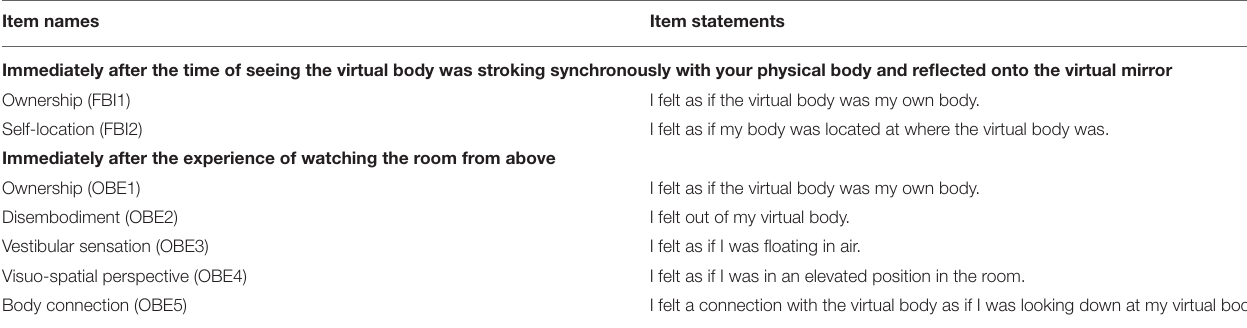
TABLE 1 | The list of self-report questionnaire items for full-body ownership illusion and out-of-body experience